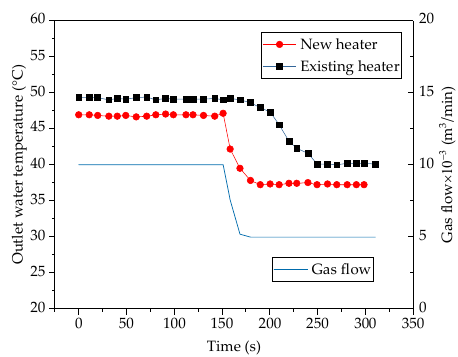
Figure 9. Water temperature change with fluctuation.